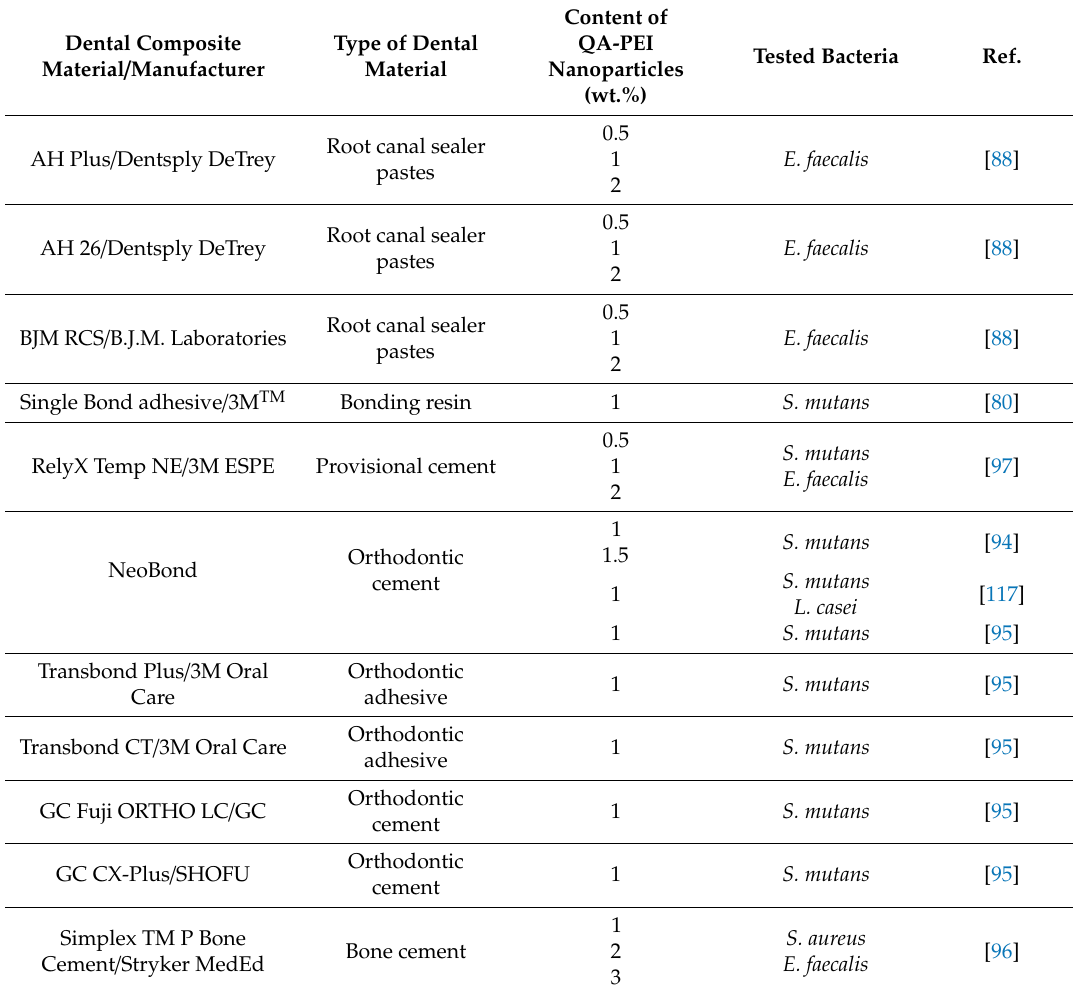
Table 4. Commercially-available dental materials tested for antibacterial activity after modification with QA-PEI